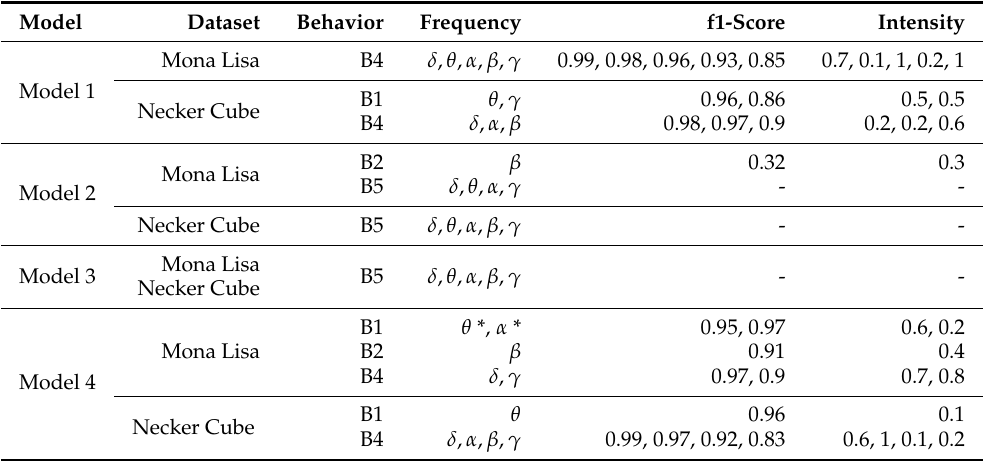
Table 8. The results of using the models with Adam optimizer for intensity classification. Model